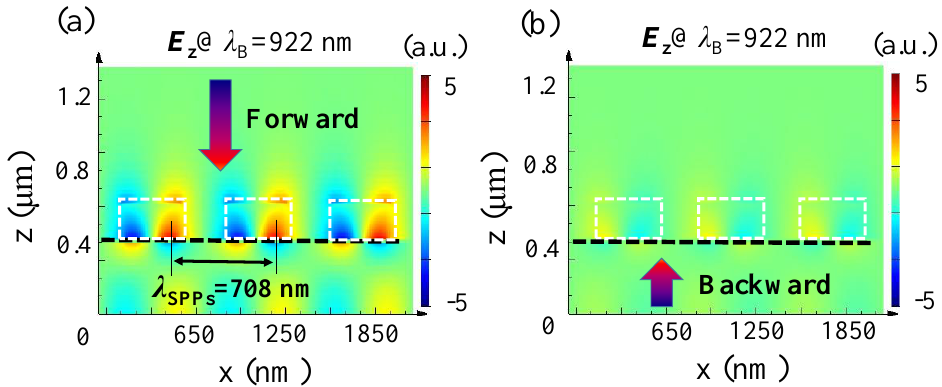
Figure 3. Electric-field E z distributions along the x-z plane at λ B = 922 nm under forward ( a ) and backward ( b ) illumination.